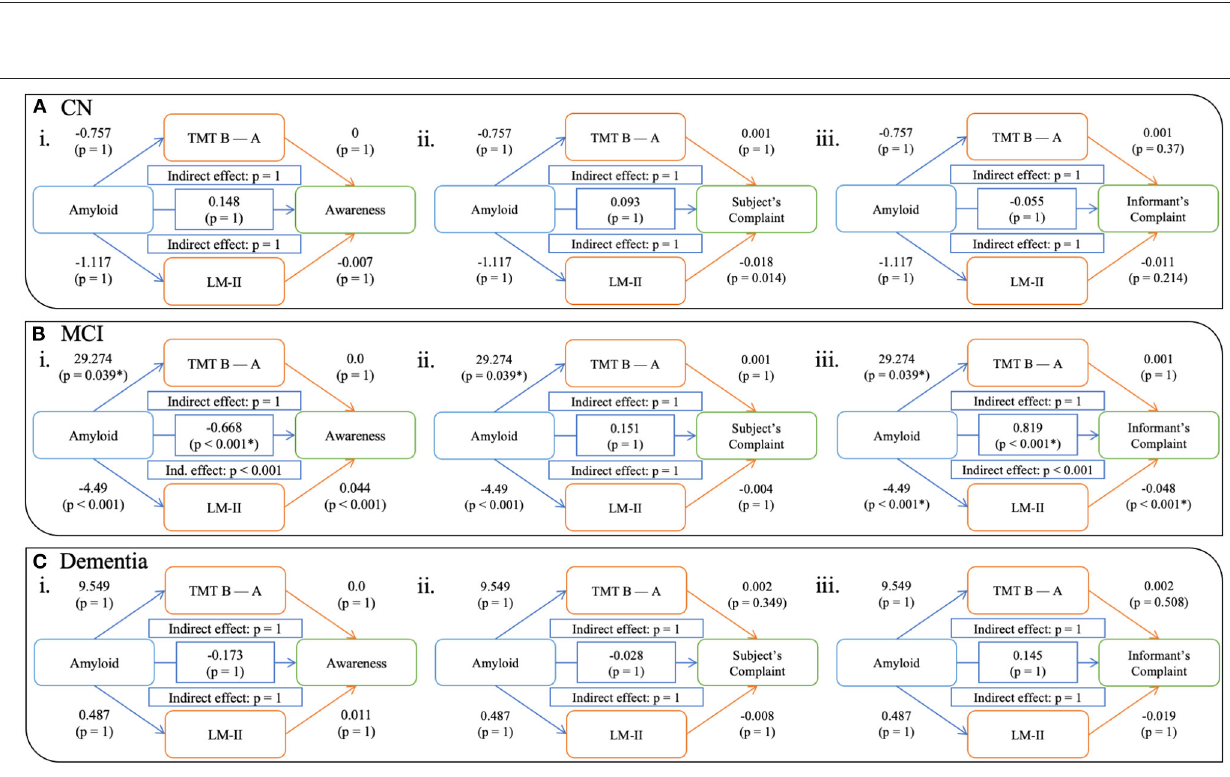
FIGURE 2 | Models showing the mediation of EM and EF on the relationship between amyloid and awareness (i), subjective complaints (ii), and informant’s complaints (iii) in (A) the whole sample and (B) the progressor and dementia group. Notes: TMT B-A = Trail Making Test, Time B minus Time A; LM-II = Logical Memory Delayed Recall. All p -values are corrected for multiple comparison.